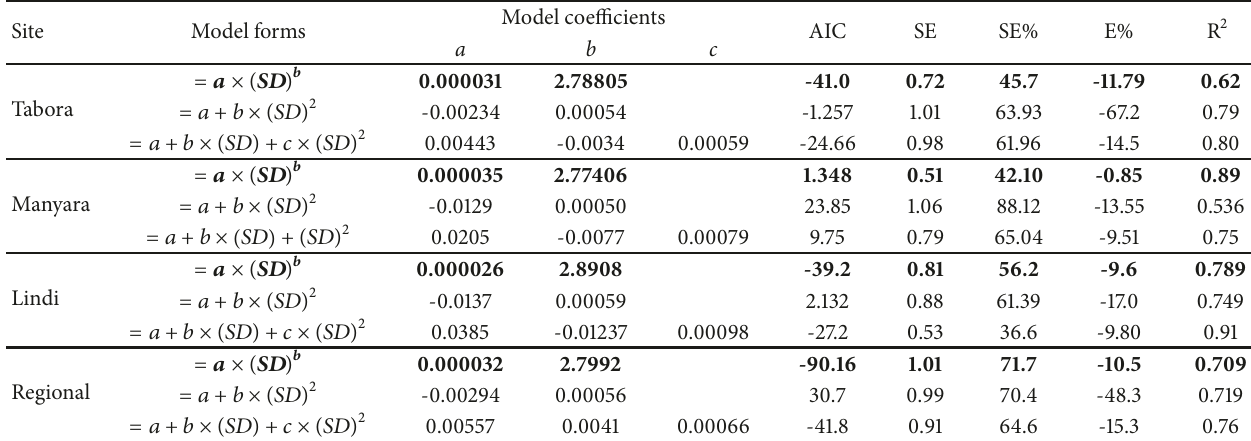
Figure 6: Residual plots of selected sites and regional volume models. Table 4: Volume model coefficients and